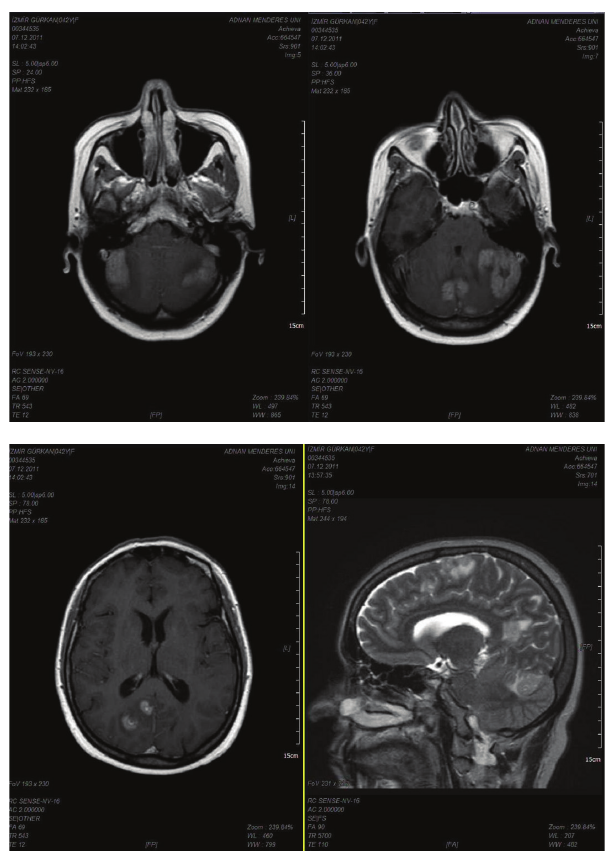
Figure 1: Magnetic resonance imaging scans demonstrating multiple brain